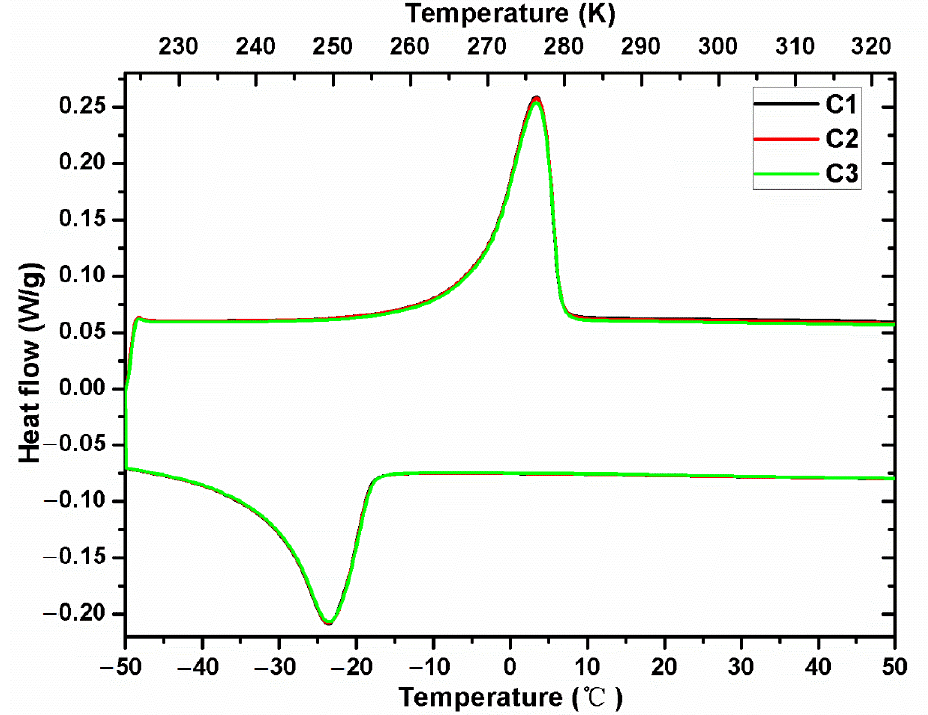
Figure 14. DSC testing result of heat treated Ti-Ni-Hf-Cu-Nb low M s alloys show narrow transfor- mation peaks and stable transformation behavior with similar transformation temperature to the as-fabricated sample.